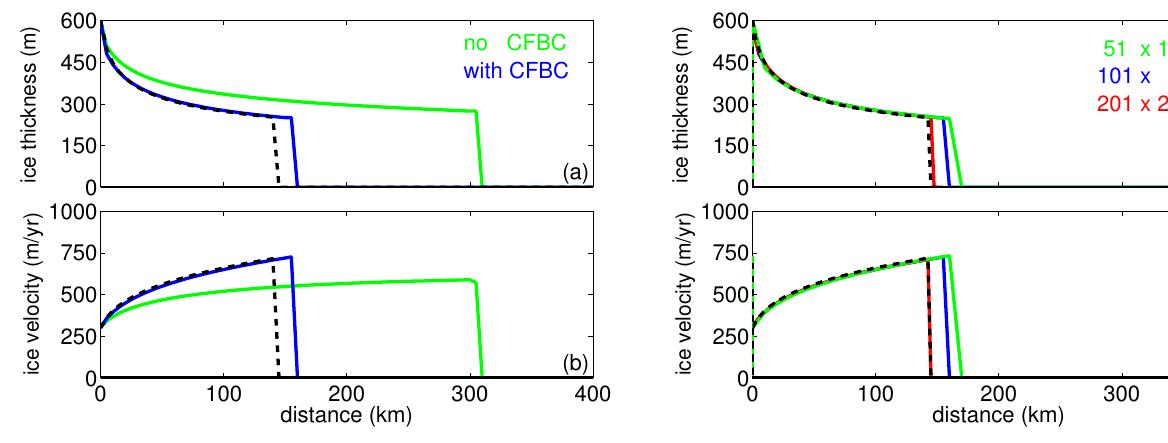
Fig. 4. Profiles of ice thickness (top) and velocity (bottom) in flow- line case in lateral view after evolution time 1000yr. Fixed Dirich- let boundary on the left and calving front on the right hand side of the computational domain. Blue: the result with applied CFBC al- ready in steady state. Green: with shelf-extension scheme and still advancing. Black dashed is the expected profile from analytical so- lution in steady state when cut off at 250m ice thickness. In both cases a resolution of 101 × 5km, adaptive time stepping and vari- ant 1 of residual mass treatment are used.